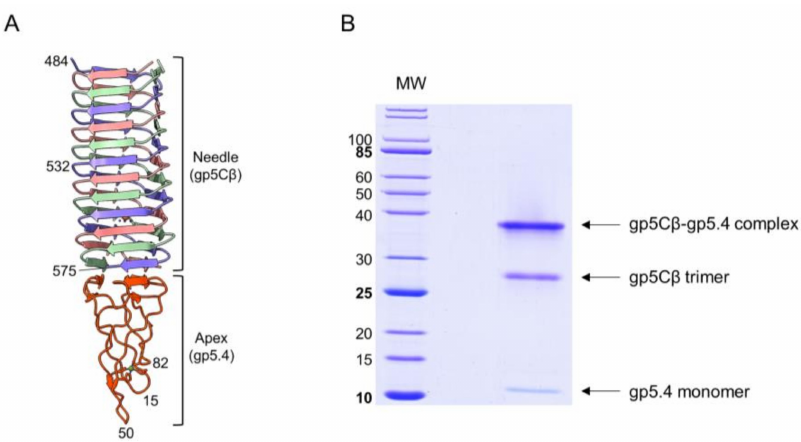
Figure 2. ( A ) Fragment of central-spike-complex structure comprising the amino acid residues 484–575 of gene 5 with the entire gp5.4. Each chain is a distinct colour. Residue numbers given for strategic positions. ( B ) Purification of central spike complex. Coexpression of the amino acid residues 484–575 of gp5 and gp5.4 resulted in the gp5C β –gp5.4 complex (apparent MW = 38 kDa). The complex partially dissociated after SDS-PAGE into a 26 kDa gp5C β trimeric helix and a 12 kDa monomeric 5.4 apex.